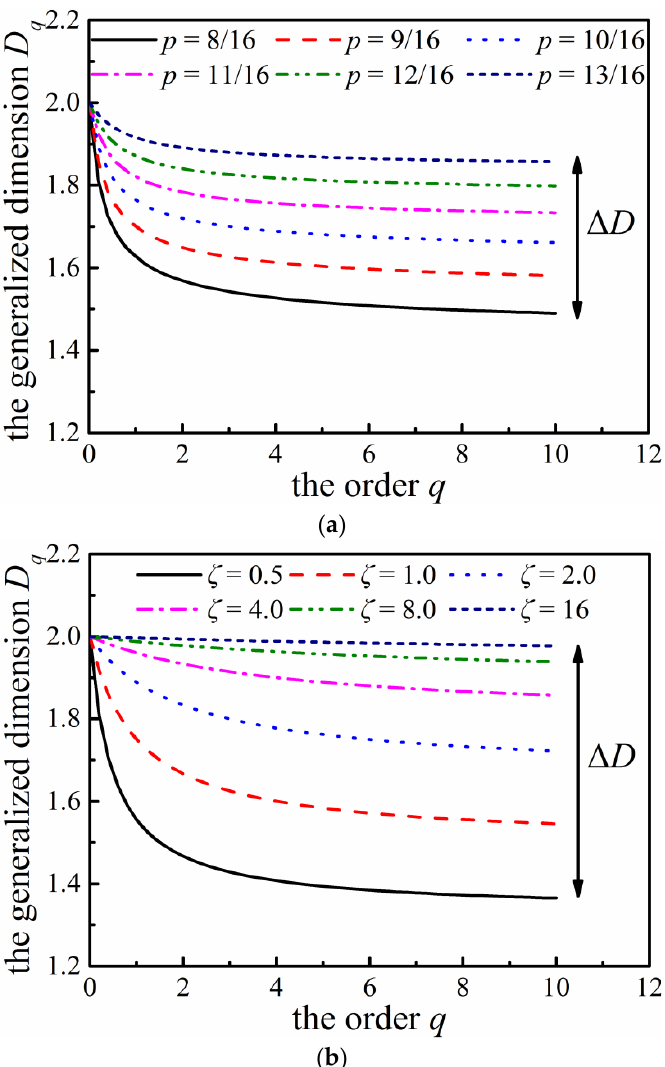
Figure 9. Structural heterogeneity characterized by the range of the Rényi dimension for ( a ) the two-parameter binomial multiplicative cascades and ( b ) the compound Pois-son cascades.